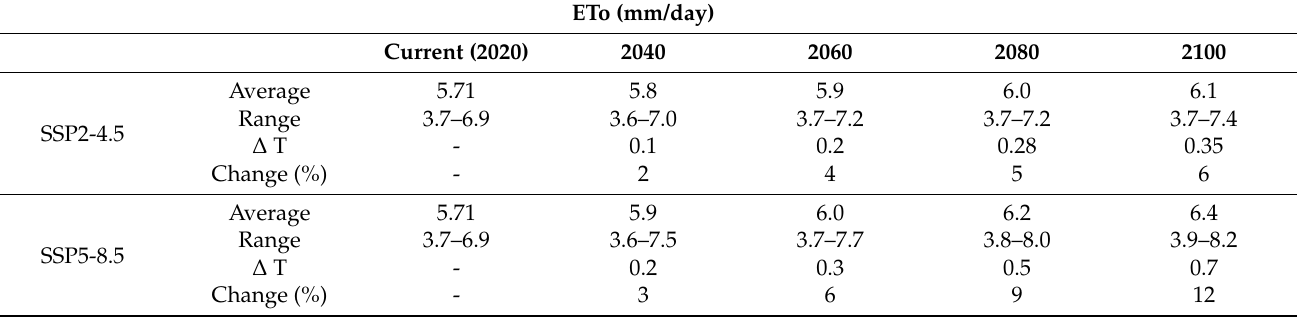
Table 5. Daily ETo (average, range, difference, and change) for 2040, 2060, 2080, and 2100 under SSP2-4.5 and SSP5-8.5 using data from the four CMIP6 climate models, with current condition (2020) for the 13